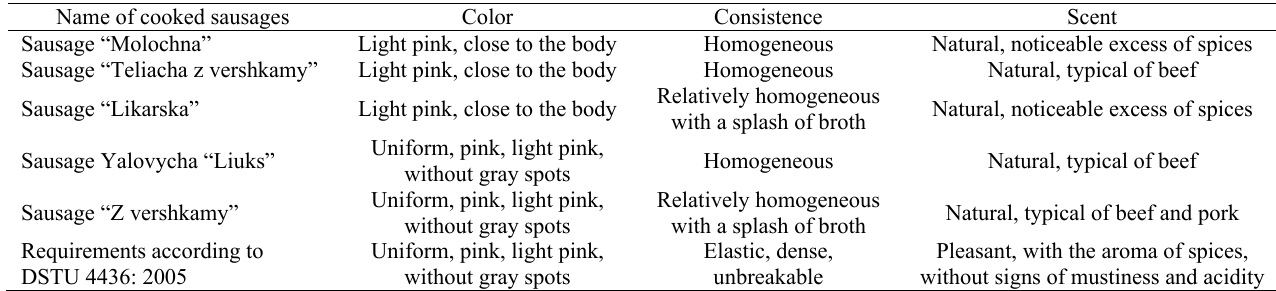
Physical indicators of quality assessment of cooked sausages Kind of sausage